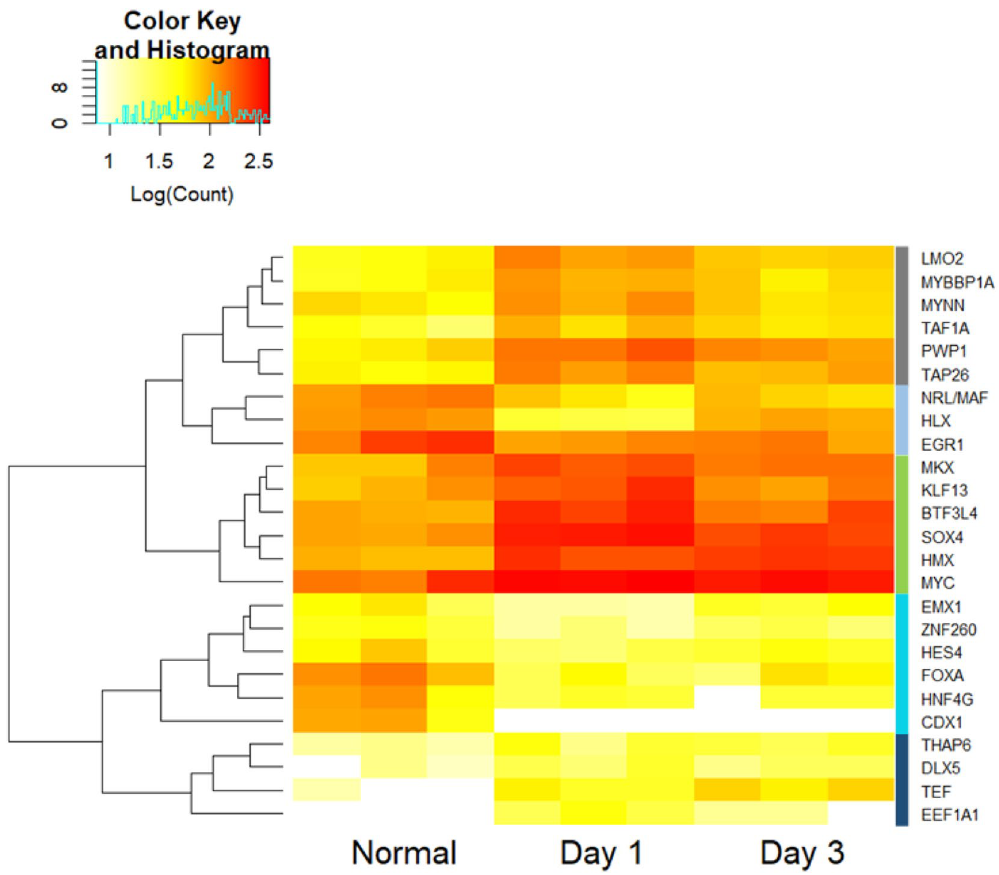
Figure 5. Heatmap of differentially expressed transcription factors (DETFs) in non-regenerating stage mesentery (Normal), and regenerating (days 1 3) intestines. DETFs showing a similar expression profiles are grouped in the dendrogram and labeled by colors in the right part of the heatmap. Logarithm count measures for expression values encompass non-negative integer values from the expression